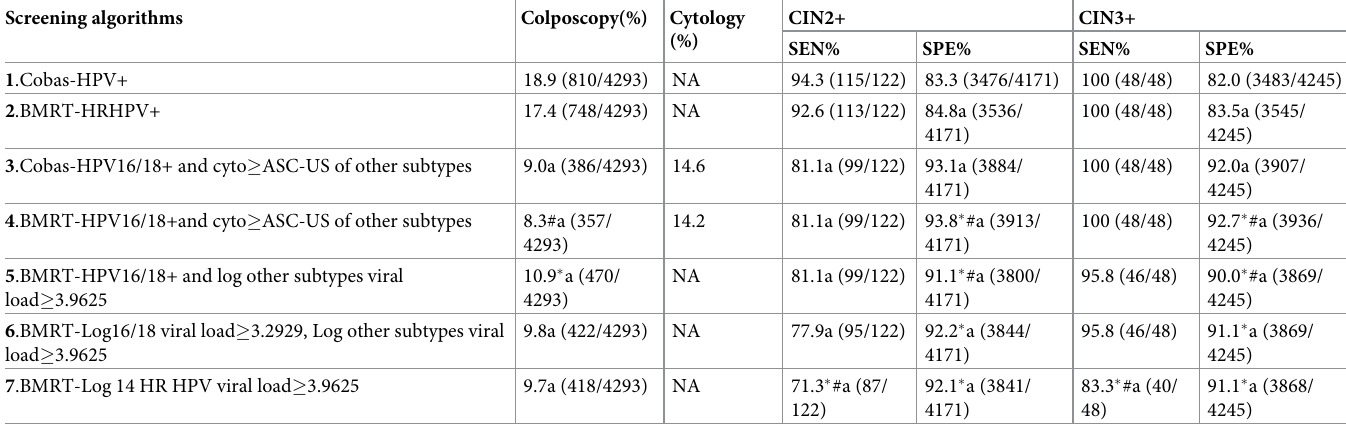
The triage strategy for colposcopy referral recommended by the current guidelines (algorithm have abnormal cytology. Algorithm #3 is then compared to three algorithms using Compared with algorithm #3, the sensitivities of algorithms #5 and #6 for CIN2+ and CIN3 + were comparable (P > 0.05); and the specificities of algorithms #5 and #6 were lower. (P < 0.05). The colposcopy referral rate of algorithm #5 was comparable (P > 0.05), but colpos- copy referral rate of algorithm #6 was slightly increased (P < 0.05). The sensitivity and specific- ity of algorithm #7 for CIN2+ and CIN3+ were lower than that of algorithm #3 (P < 0.05); and the colposcopy referral rate of algorithm #7 was higher than that of algorithm #3. Table 4. Screening algorithms. Screening